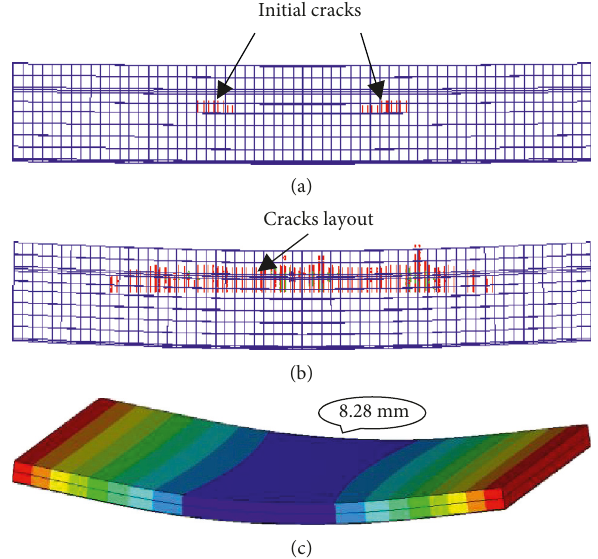
Figure 8: Results of nonlinear analysis: (a) crack appears; (b) cracks layout at limit state; (c) structural